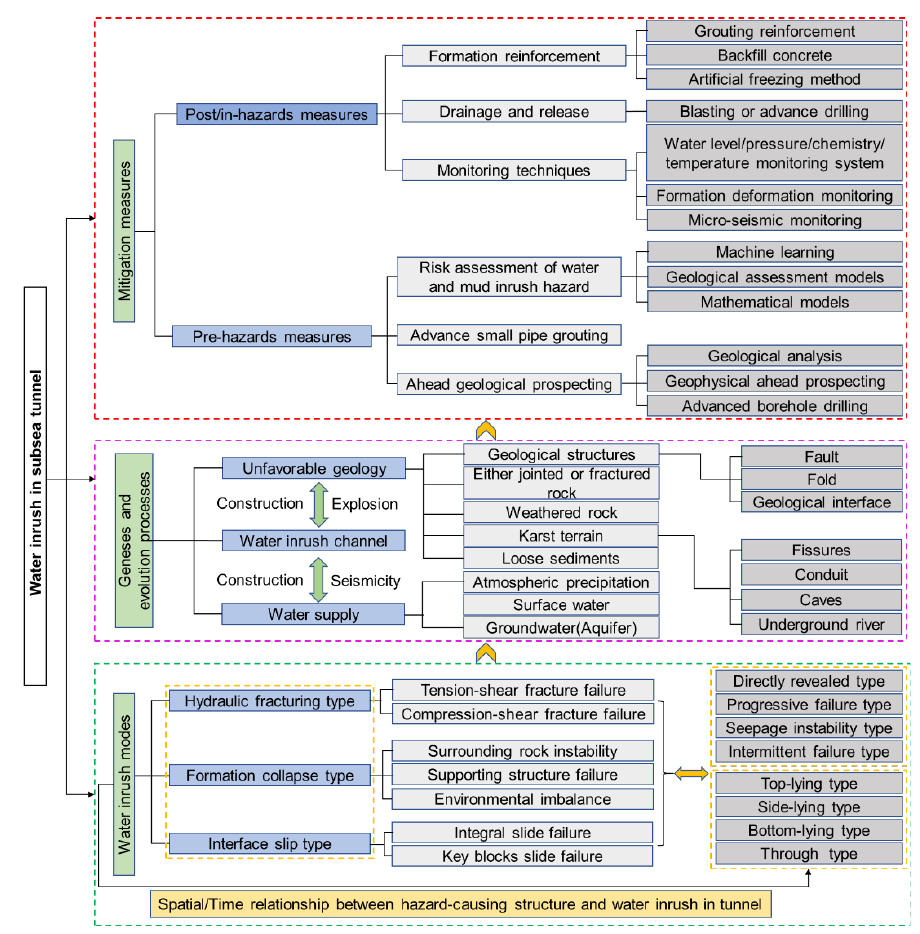
Figure 3. Taxonomy of research literature on water inrush in subsea tunnel.